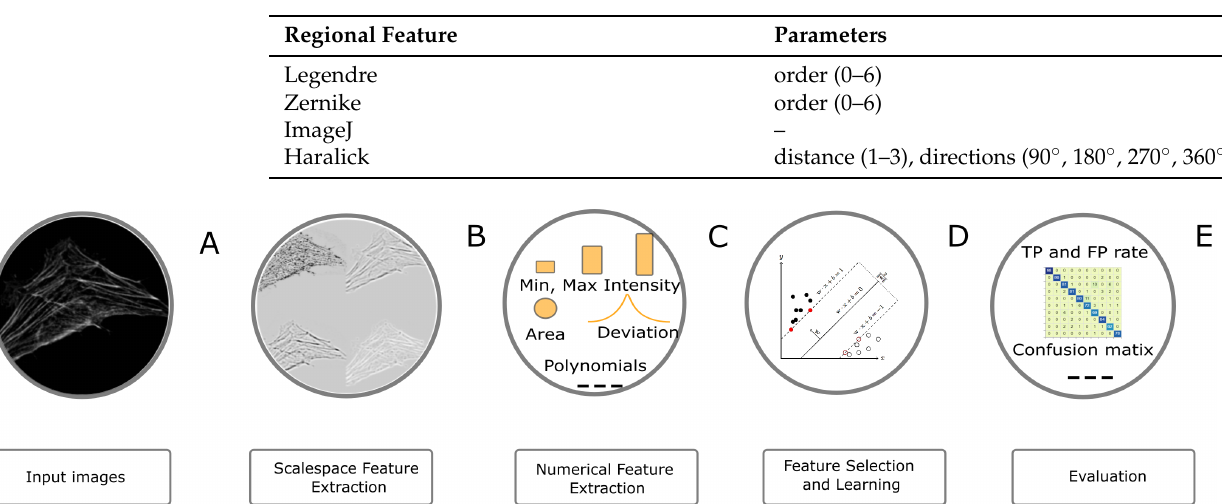
Table 6. Regional Features and parameters used for Hela and HEp-2 data sets.